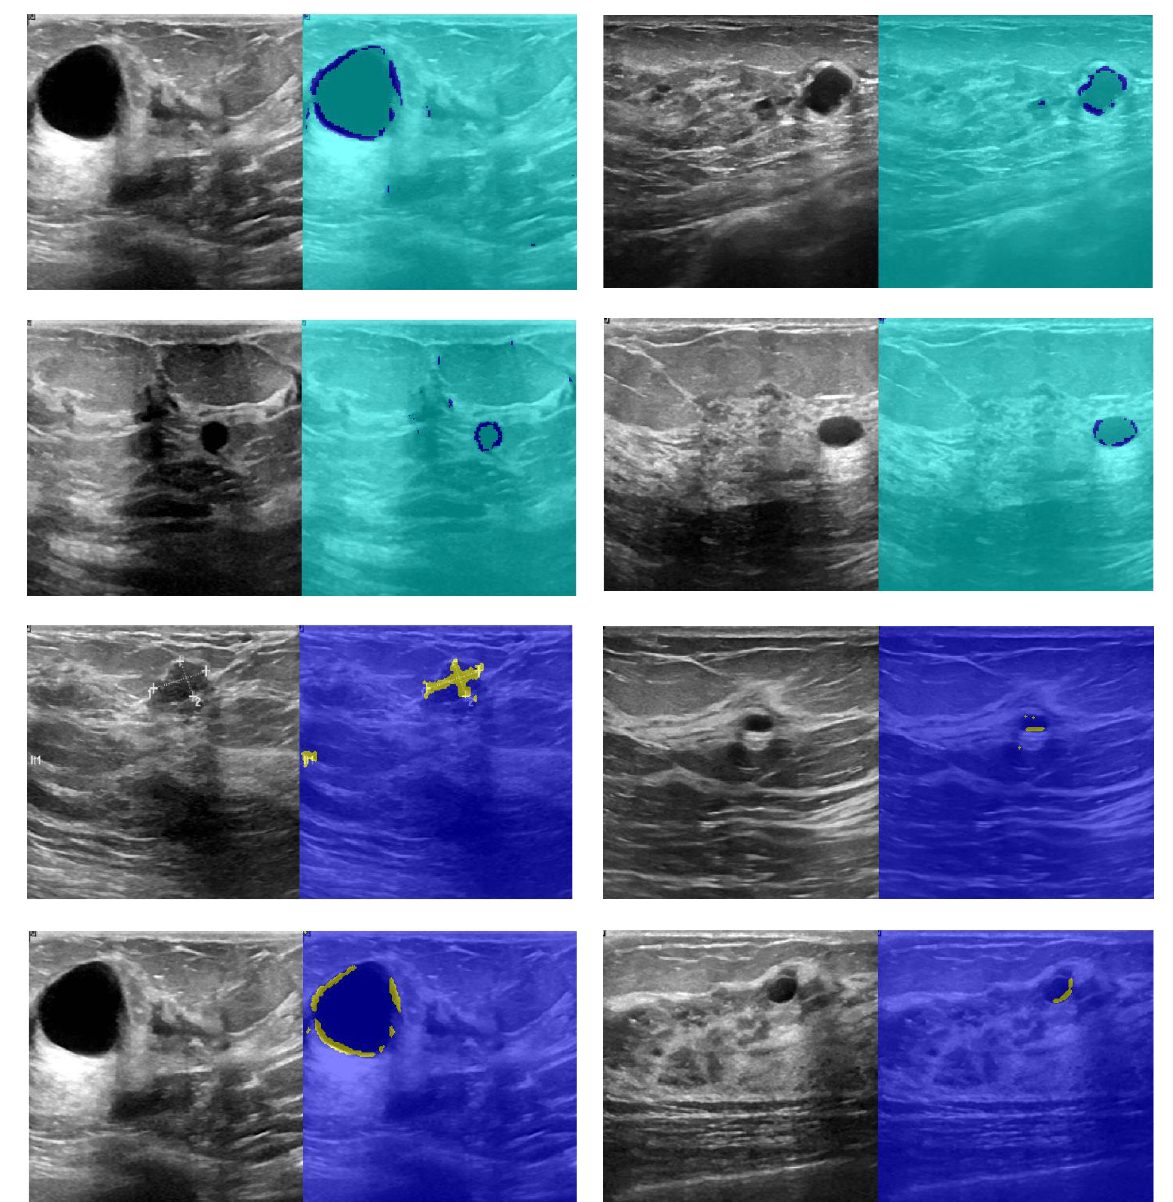
Figure 10. Results of CNN network cancer tumor segmentation.